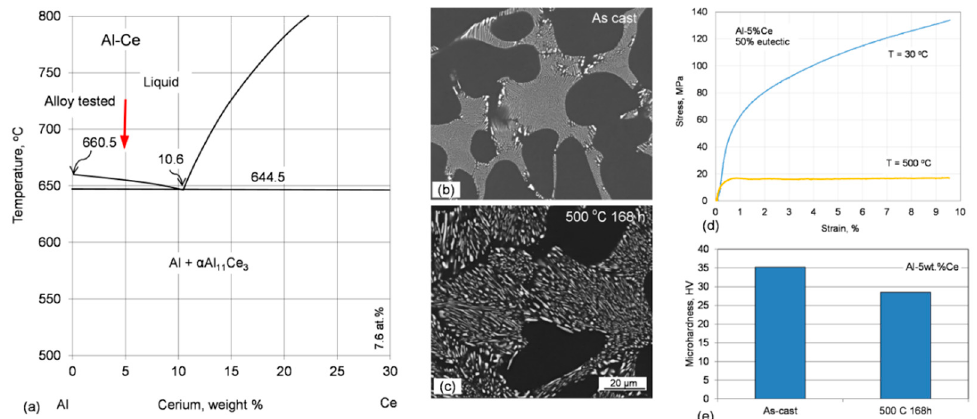
Figure 25. Thermal stability of Al − 5 wt.% Ce binary alloy: ( a ) portion of Al − Ce binary diagram showing location of commercially important eutectic [124]; ( b ) eutectic morphology after casting; ( c ) eutectic morphology after heating for 168 h at 500 °C; (d) stress versus engineering strain plot for alloy compression at room and at 500 °C; ( e ) hardness after casting and heating for 168 h at 500 °C.